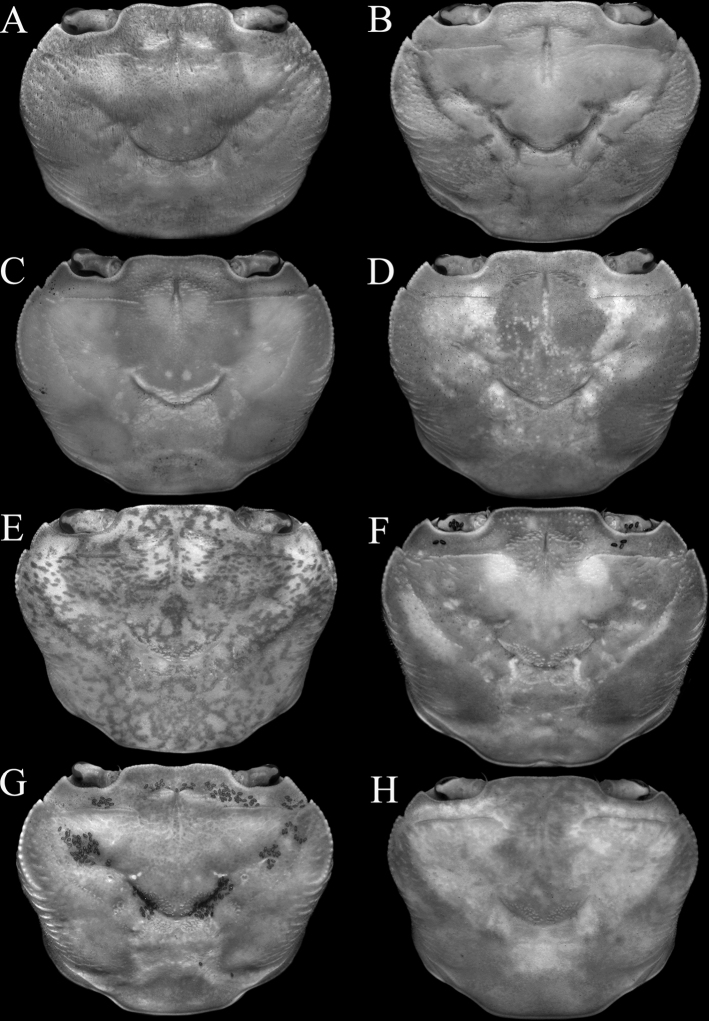
Dorsal view of carapace AJohora
intermedia Ng, 1986, holotype male (19.8 × 15.1 mm) (ZRC 1984.6529), Pahang BJ.
tahanensis (Bott, 1966), male (30.7 × 25.5 mm) (ZRC 1984.6795), Pahang CJ.
thoi Ng, 1990, holotype male (41.2 × 33.3 mm) (ZRC 1989.2249) Terengganu DJ.
hoiseni Ng & Takeda, 1992, holotype male (25.1 × 21.1 mm) (ZRC 1984.6673), Kelantan EJ.
thaiana Leelawathanagoon, Lheknim & Ng, 2005, paratype male (22.2 × 18.6 mm) (ZRC 2006.0052), Thailand FJ.
booliati sp. nov., holotype male (34.6 × 30.0 mm) (ZRC 2020.0072), Pahang GJ.
erici sp. nov., holotype male (38.3 × 32.0 mm) (ZRC 2020.0360), Perak HJ.
michaeli sp. nov., holotype male (22.7 × 19.2 mm) (ZRC 2010.0047), Terengganu.